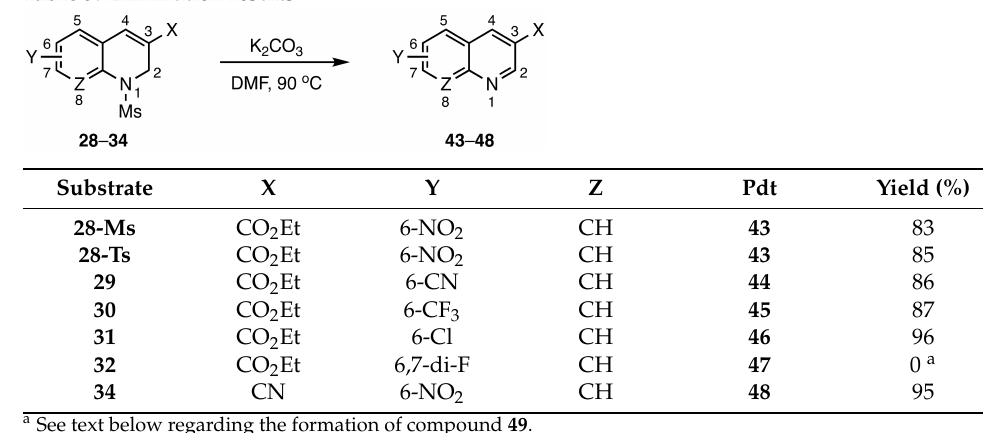
Table 3. Elimination results.